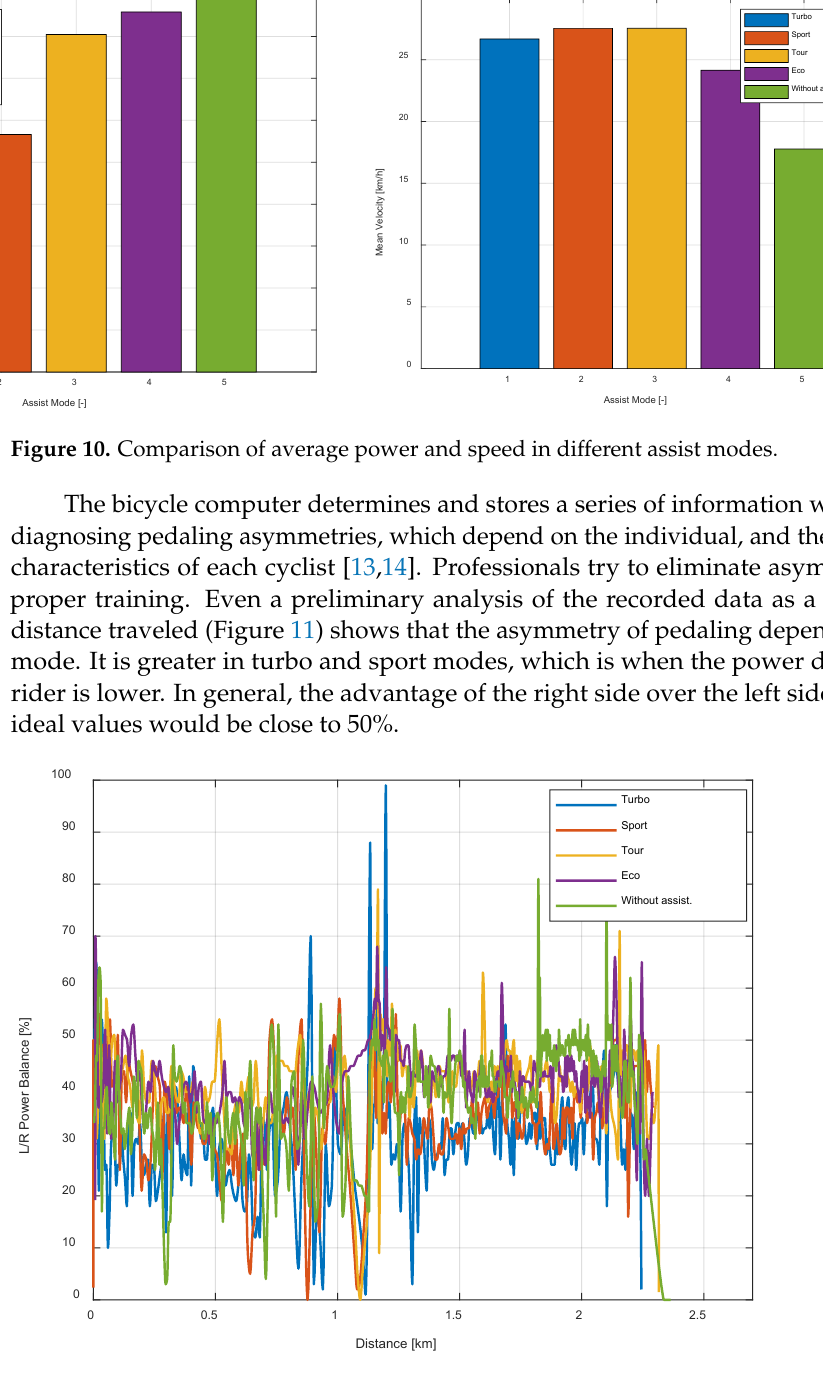
Figure 12. Left/right power balance as a function of power.